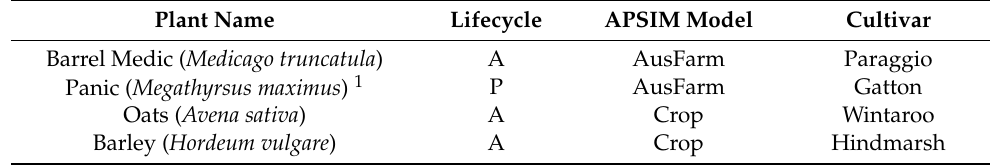
Figure 4. ( left ) Average seasonal rainfall for 2000–2020 (dark columns) and average rainfall of the lowest 20% of simulation years (open columns) and ( right ) average daily maximum (top of column) and minimum temperature (bottom of column) for ( a ) Waitchie, ( b ) Kellerberrin, and ( c ) Waikerie. Table 1. Details of the APSIM 7.9 pasture and crop options simulated in interrow. Lifecycle is A—annual;